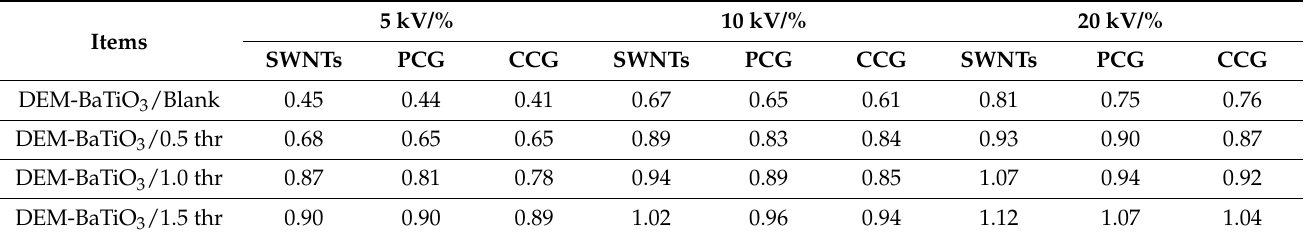
Table 5. Electro deformability data of actuating unit encapsulated with different electrodes.